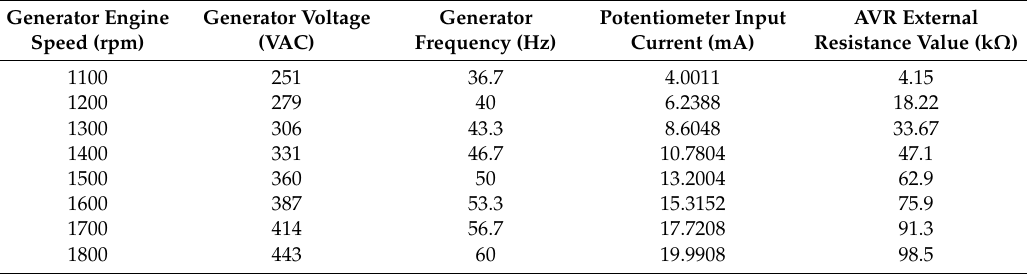
Table 3. Experimental results of the generator reference voltage with respect to changes in the system speed using the neural network